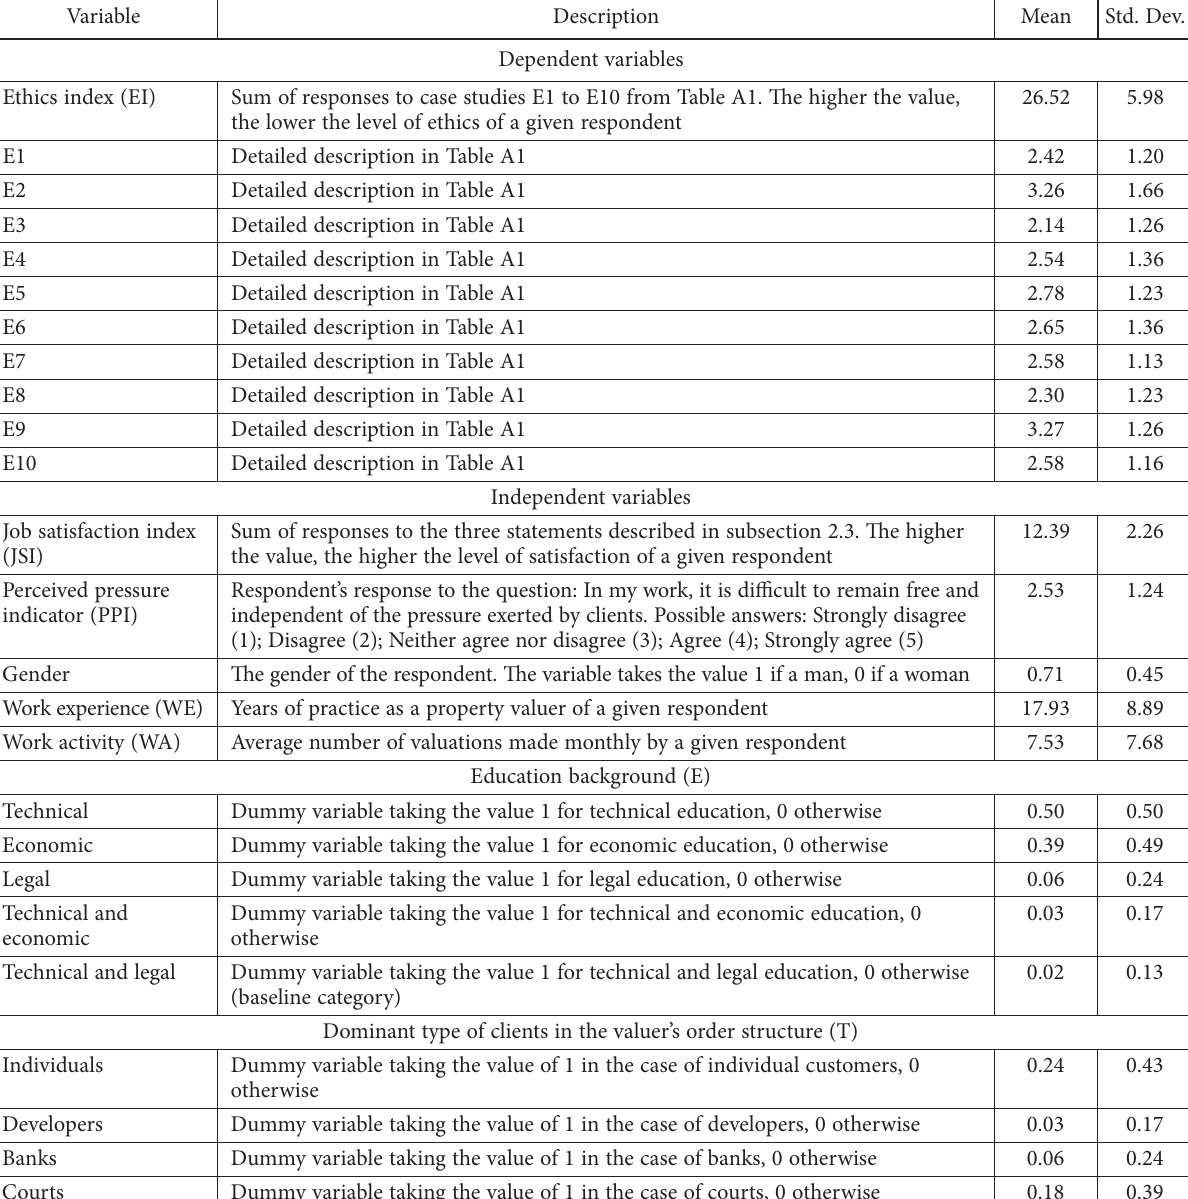
Table A2. Detailed description of the variables adopted for econometric